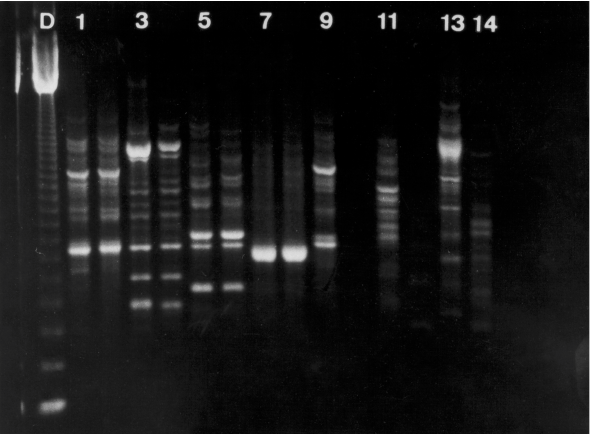
Figure 2 - Amplification products obtained with micro 11 in two indi- viduals of each Gymnotus species (lanes 1-8). D, 123-pb DNA ladder. Lanes 1,2, Gymnotus carapo ; 3,4, G. inaequilabiatus ; 5,6, G. pantherinus ; 7,8, G. sylvius ; 9 and 11, positive controls; 10, no amplification; 12, nega- tive control; 13, Eigenmannia ; 14, Pseudostegophilus